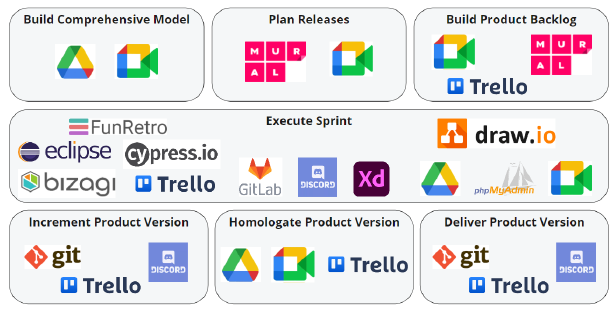
Figure 3. Case 1 process